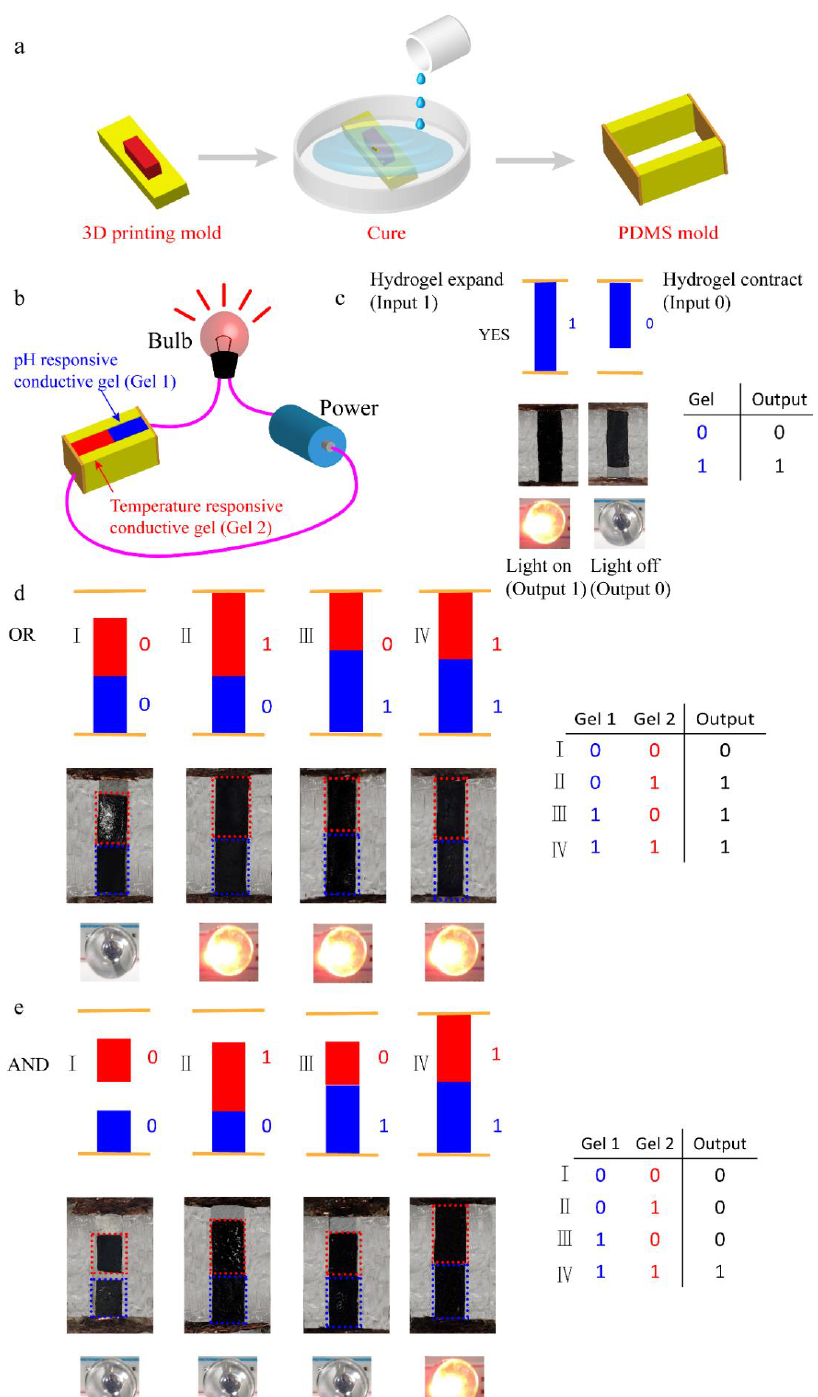
Figure 6. The design of logic gates. Schemes illustrating ( a ) preparation of molds using polydimethylsiloxane (PDMS); ( b ) using power, a bulb, PDMS molds, and stimuli-responsive conductive hydrogels to form logic gates. The red rectangles represent temperature-responsive conductive hydrogels and the blue rectangles represent pH-responsive conductive hydrogels; ( c ) thedi ff erent states of the YES gates and the truth tables; ( d ) the di ff erent states of the AND gates and the truth tables; ( e ) the di ff erent states of the OR gates and the truth